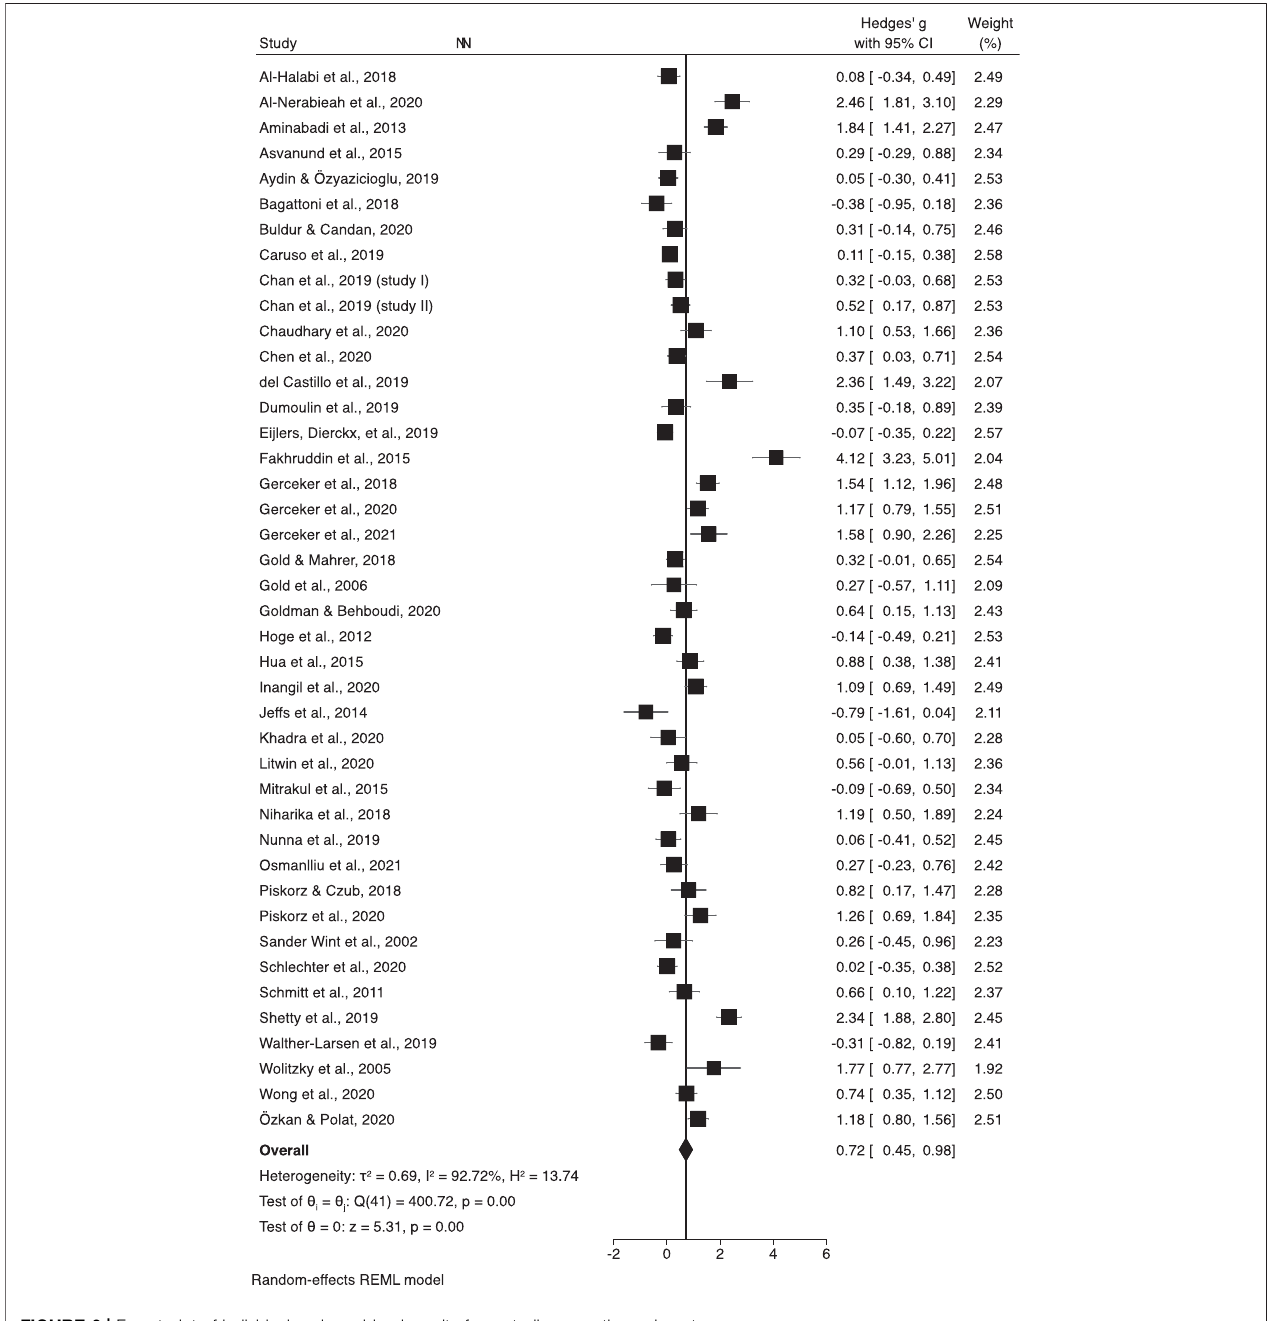
Frontiers in Virtual Reality |